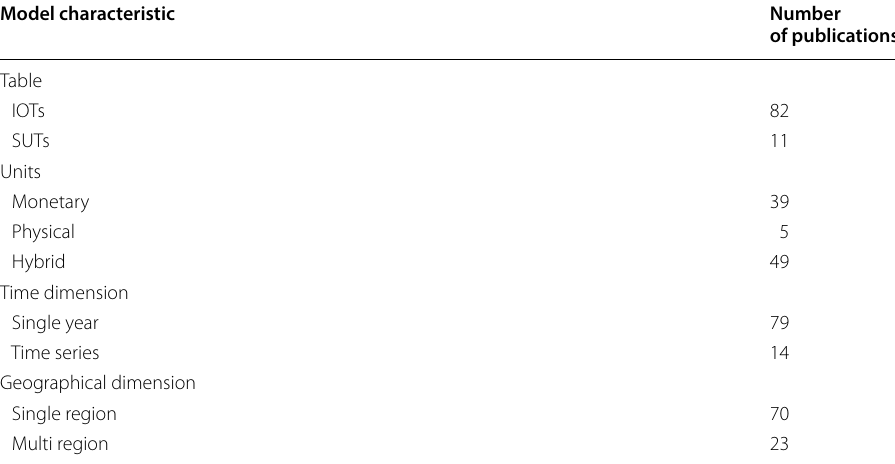
Table 3 Summary of EEIOA model characteristic by type of table, units, time and geographical